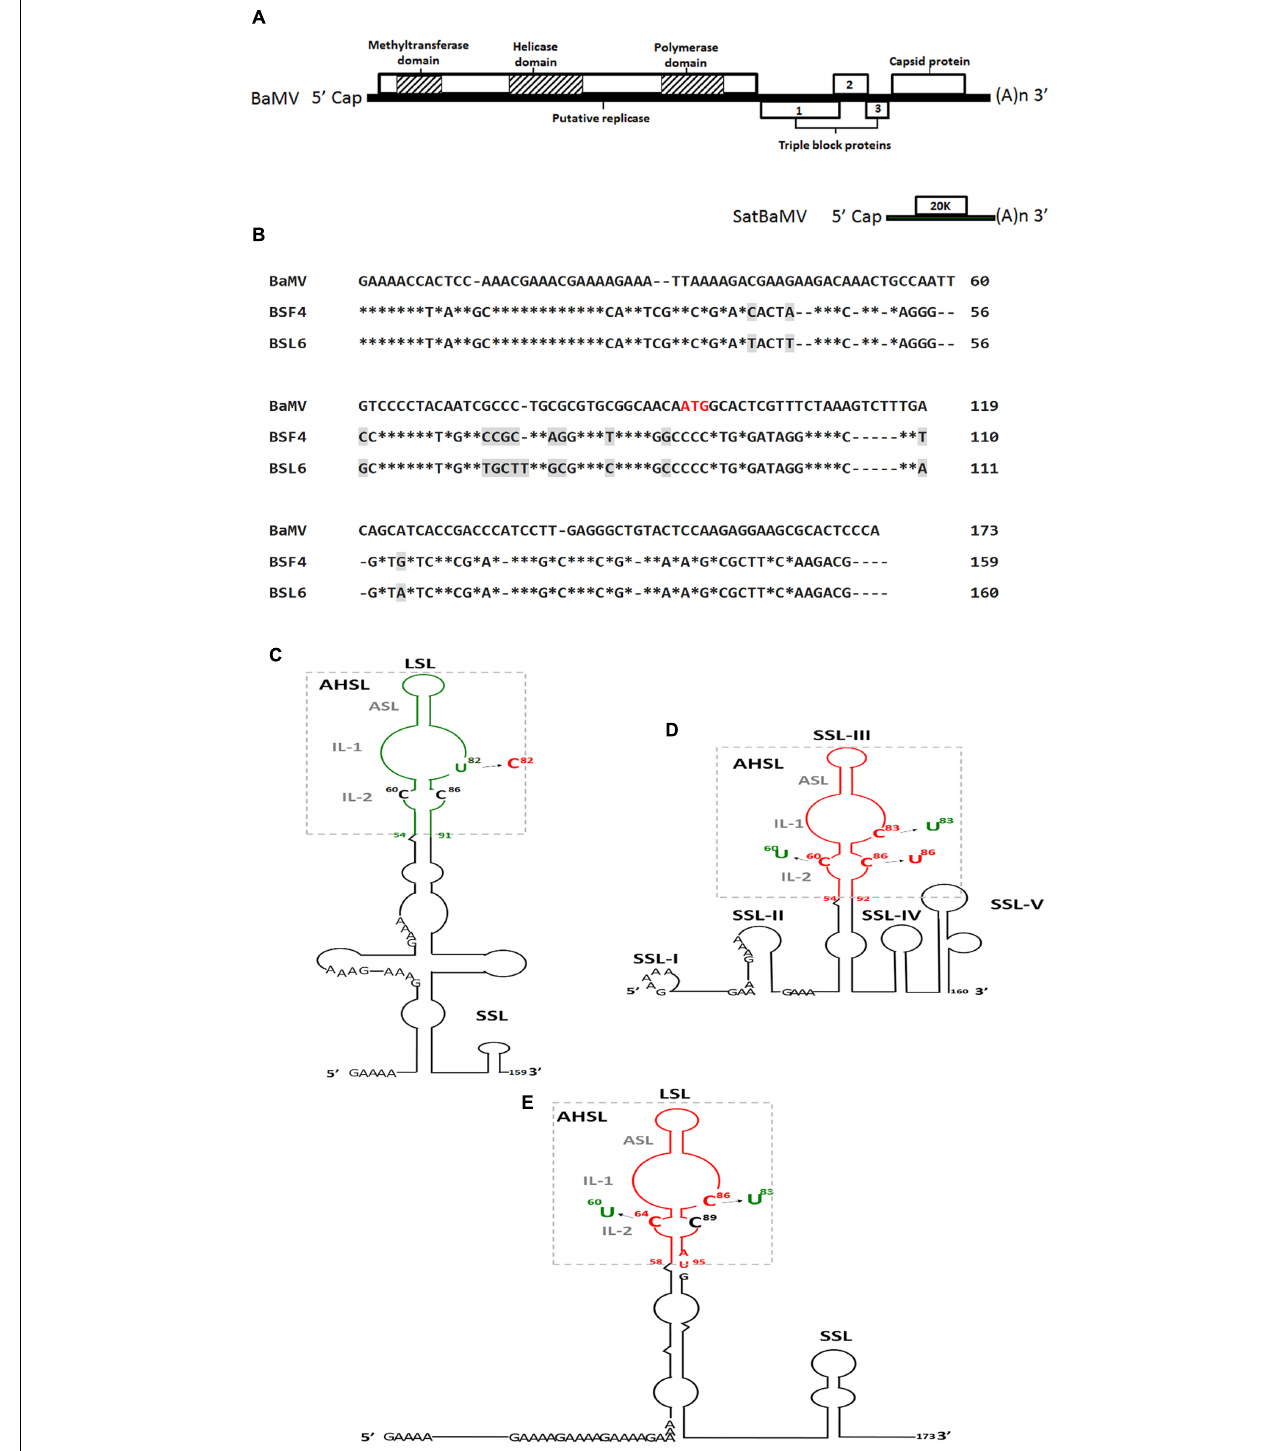
FIGURE 1 | Genome map of satellite Bamboo mosaic virus (satBaMV) and BaMV (A) , sequence alignment of BaMV, BSF4, and BSL6 5 (cid:48) -UTR (B) and secondary structures of 5 (cid:48) -UTR of satBaMV, BSF4 (C) and BSL6 (D) and 5 (cid:48) -termini of BaMV (E) and their derived mutants. ∗ indicates identical nucleotide. Different nucleotides between BSF4 and BSL6 sequence are marked by gray shade. The apical hairpin stem loop (AHSL) structures of satBaMV and BaMV are boxed, and all contain an apical stem loop (ASL) and two internal loops (IL-1 and IL-2). The common GAAA(A) repeats in the 5 (cid:48) -UTRs are indicated. The AUG sequence indicates the start codon of the BaMV open reading frame 1 (ORF1). Green and red indicate the non-interfering and interfering type. LSL, large stem loop; SSL, small stem loop.